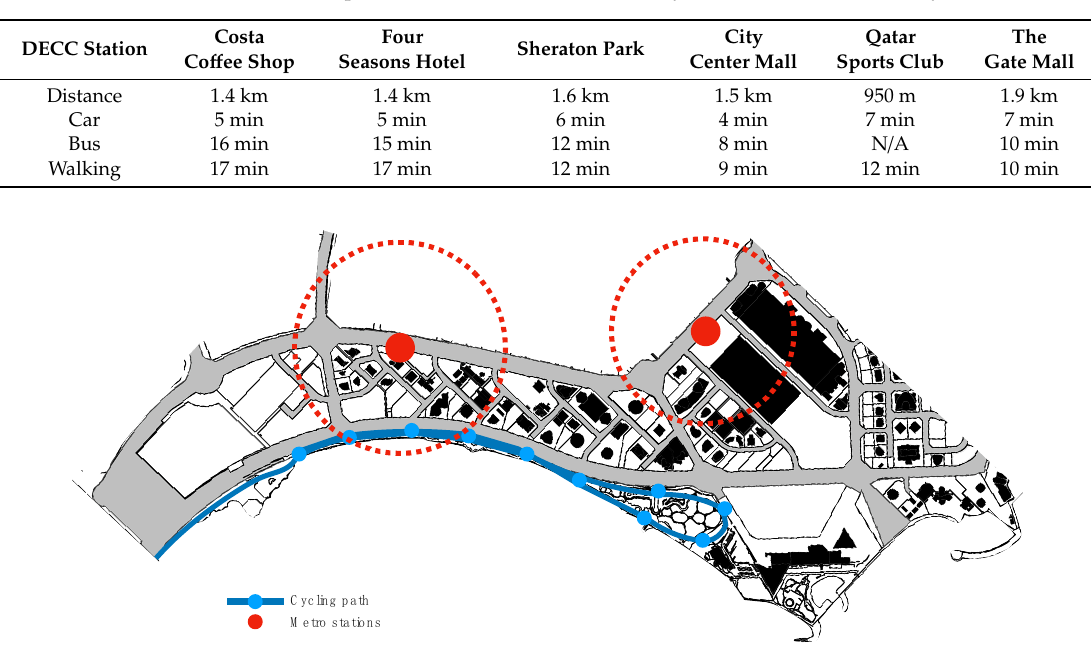
Table 3. The distance via transportation modes between West Bay Metro stations and nearby landmark.